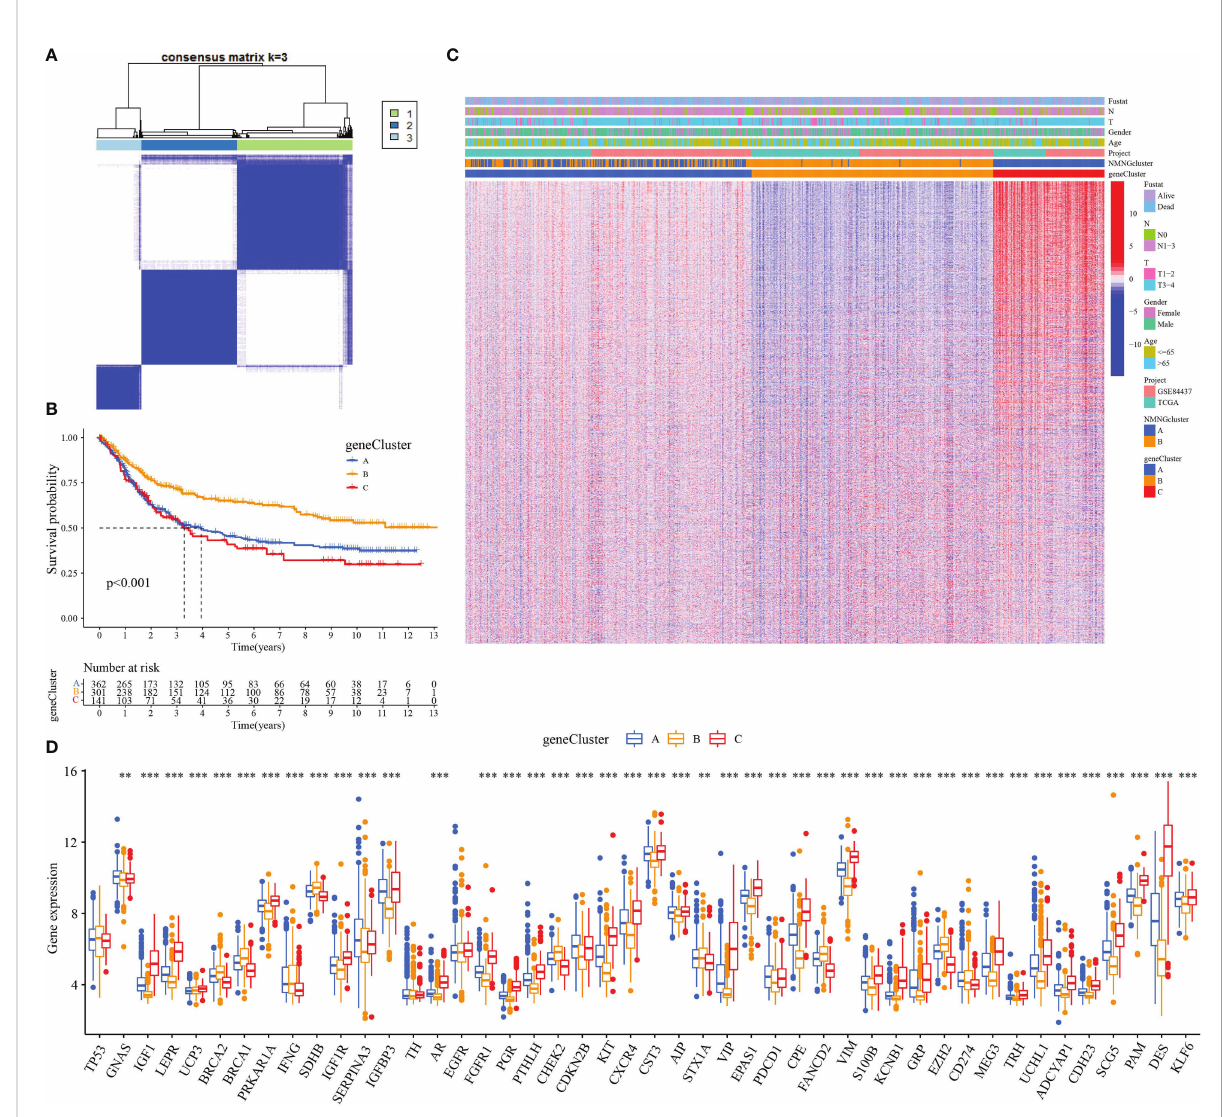
FIGURE 6 Three genomic subtypes of DEGs with prognostic signi fi cance by unsupervised cluster analysis. (A) Consensus matrix. (B) Survival analysis of gene clusters. (C) Different clinicopathological characteristics of these subgroups shown by heatmap. (D) Expression of NMNGs in STAD in three gene clusters. **P<0.01